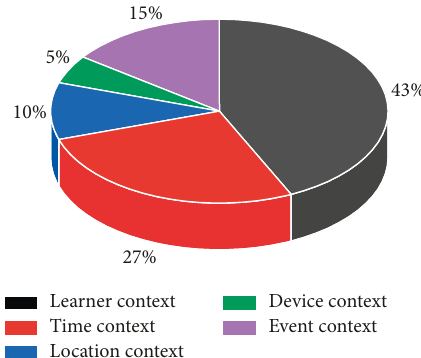
Figure 1: Pie chart of the proportion of four heterogeneous data